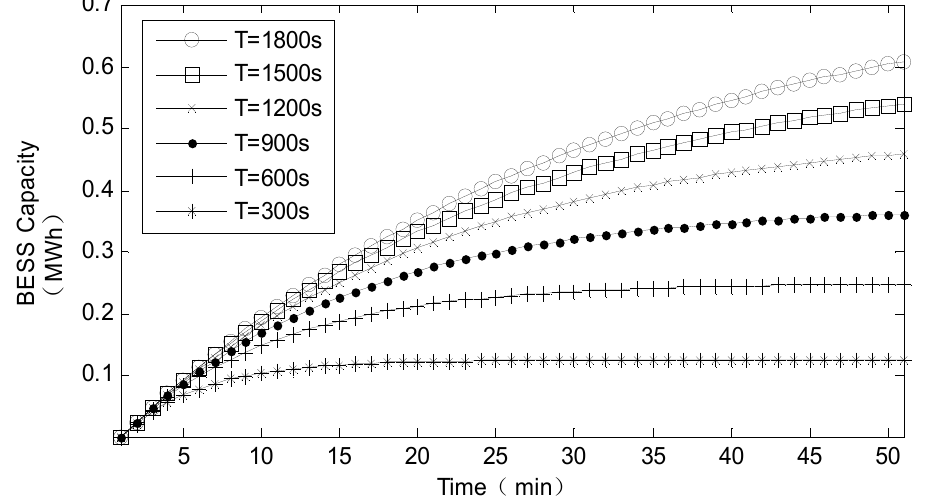
Figure 4. The relationship between the capacity of BESS and time constant T